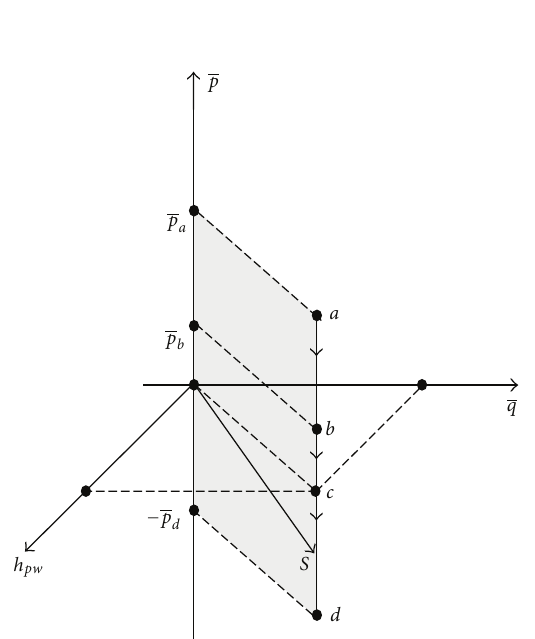
Figure 6: Power tetrahedron diagram.